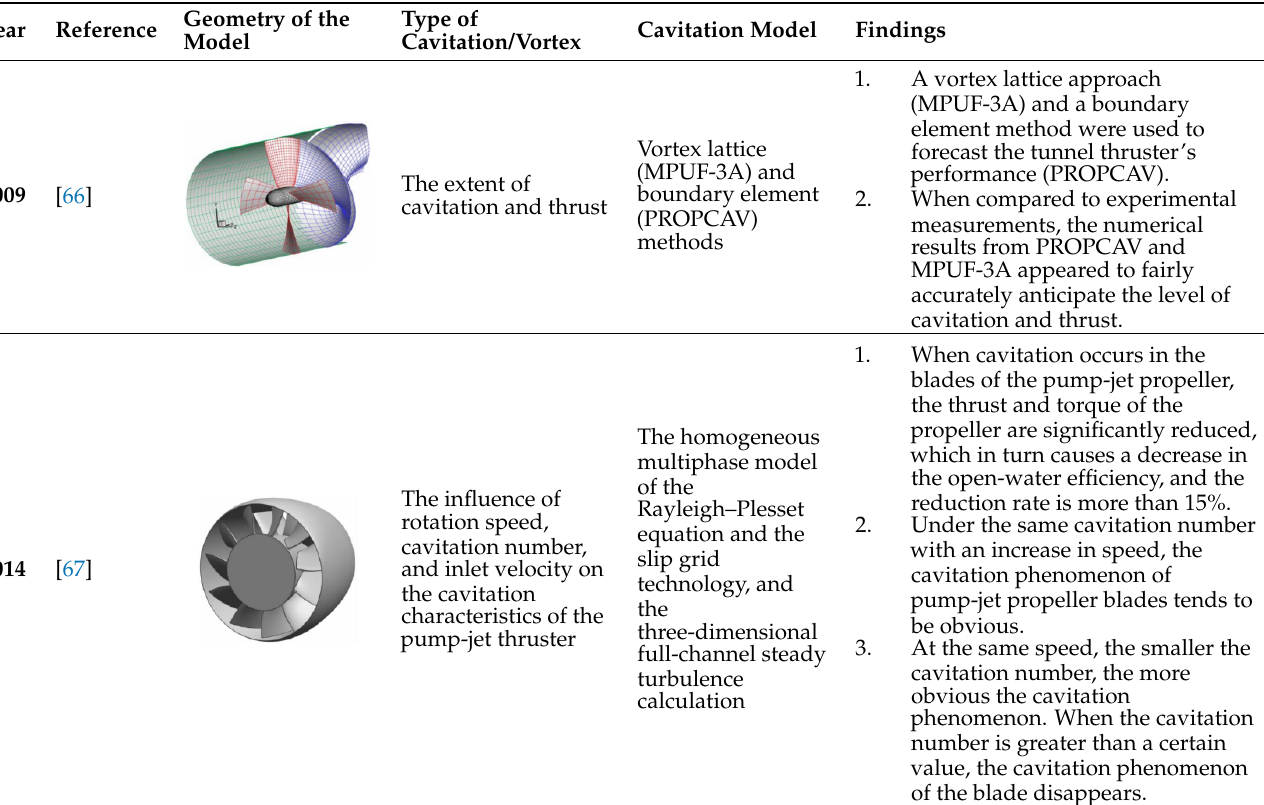
Table 4. Summary of methods for cavitation simulation and the achievements based on numerical calculations for IMP thrusters.